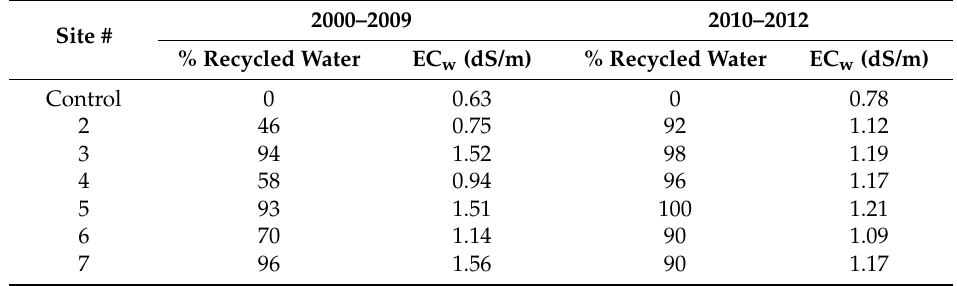
Table 2. Average electrical conductivity (EC) of applied water (EC w ) at different sites from